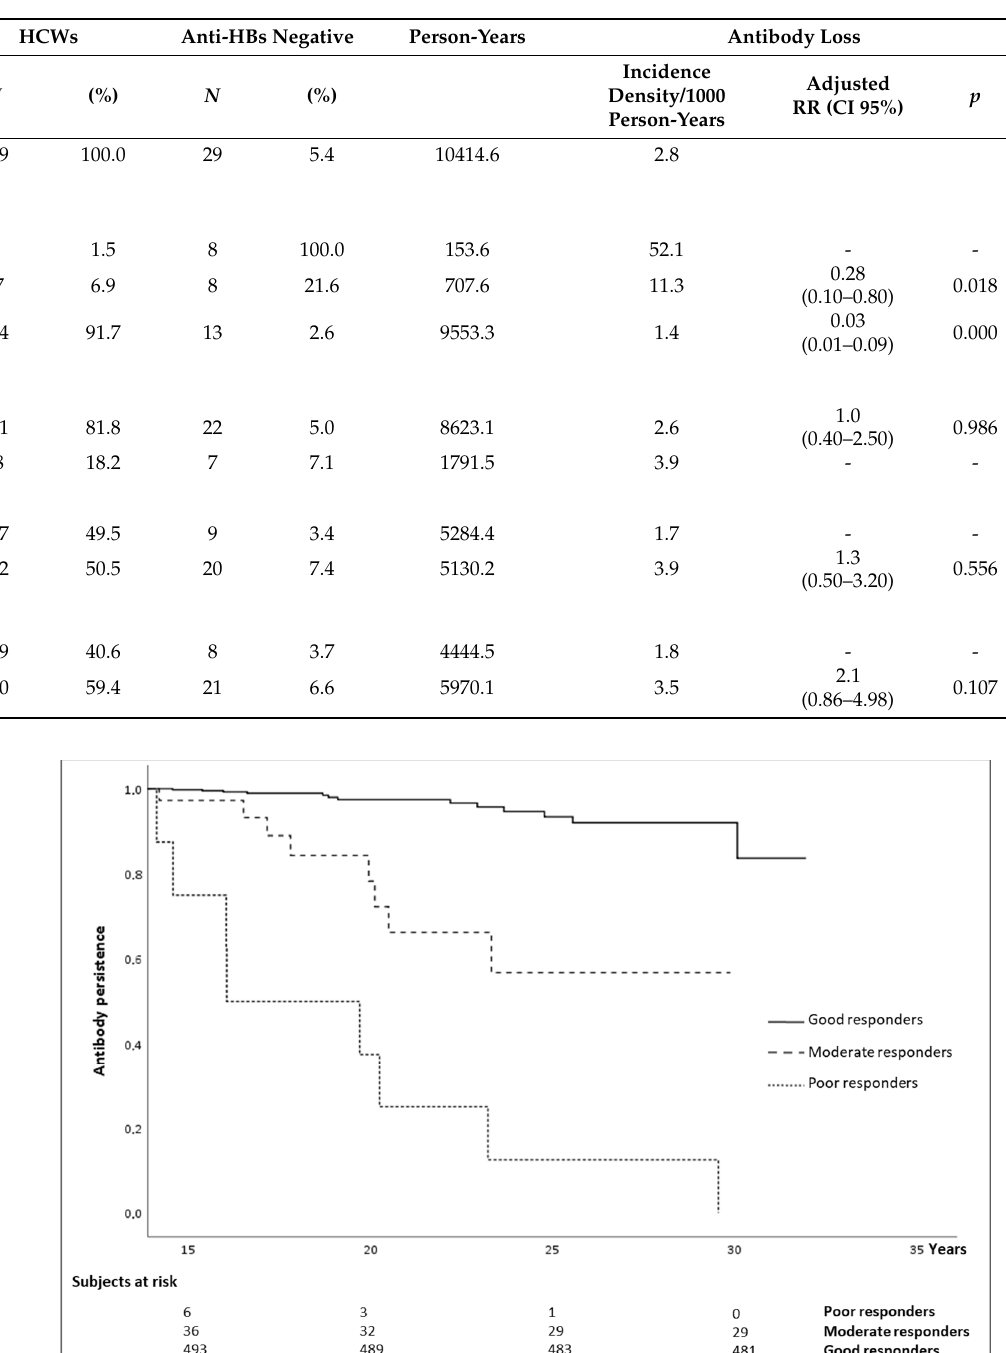
Table 1. Antibody loss at follow-up in responders to primary immunization.